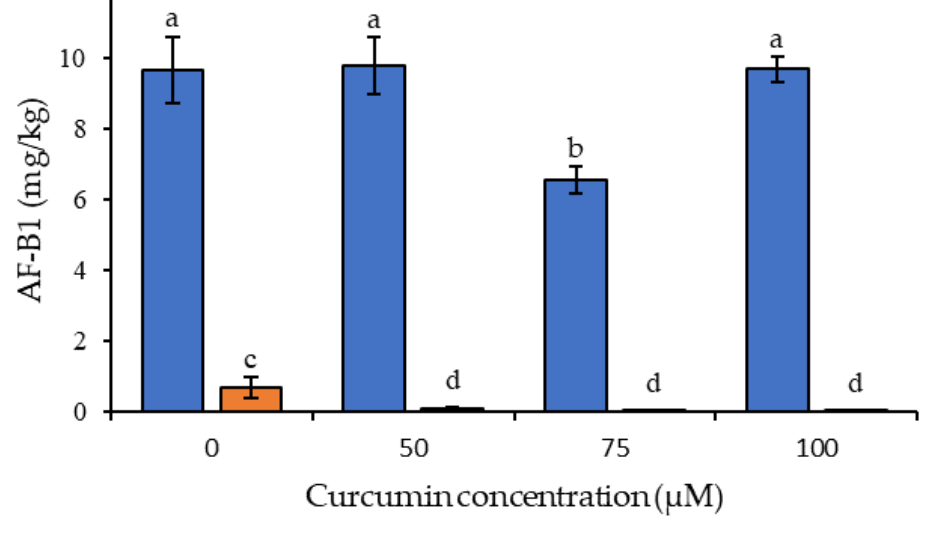
Figure 4. Effect of photosensitization on aflatoxin B1 (AF-B1) generation on Aspergillus flavus - inoculated peanuts during storage at 25 ◦ C after 7 days storage. Different letters indicate significant differences ( p < 0.05) between the treatments; n = 3 independent experiments with triplicate samples per condition per experiment.